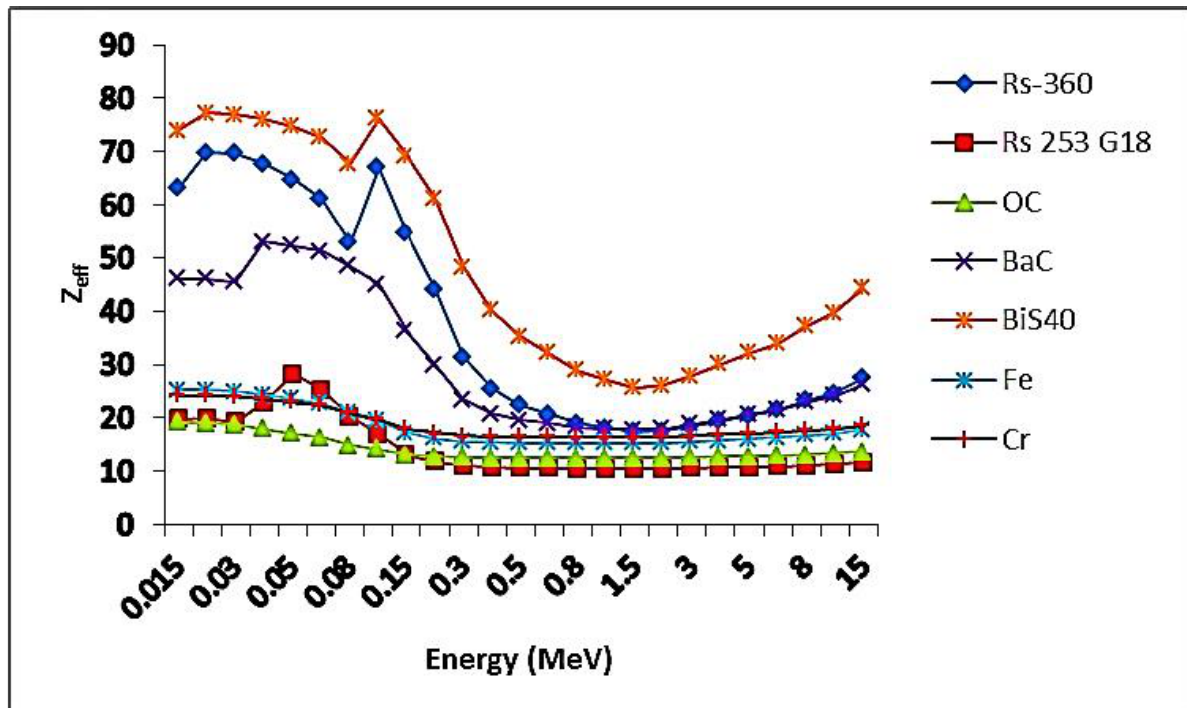
Figure 12. Comparison values of the Z eff of the present sample BiS40 with commercial materials.